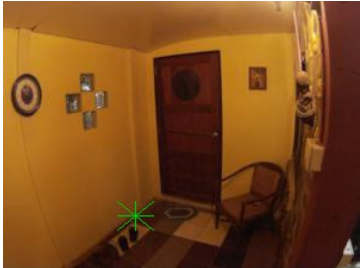
Figure 9. “Star of thickness 1”.